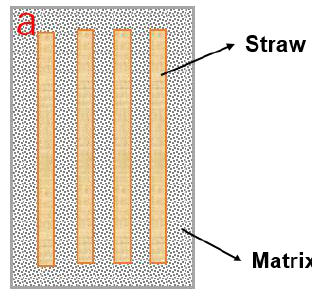
Figure 3. Distribution of straw units in the LLDPE matrix: straw ( a ), grinded straw ( b ), and slope-cut straw ( c ).